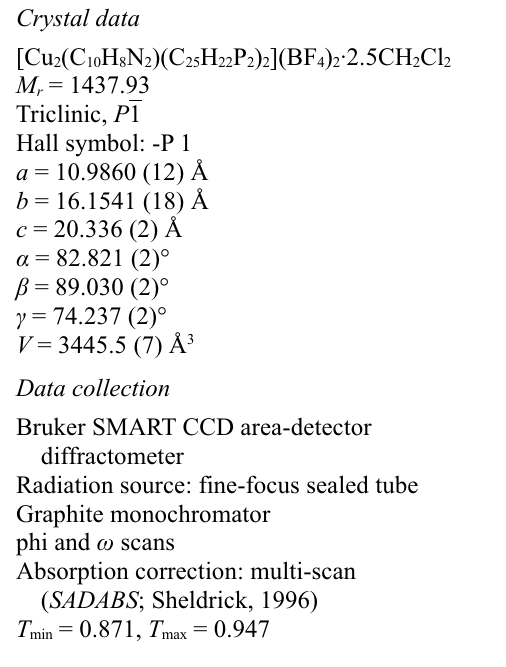
) - anions and dichloro- 4